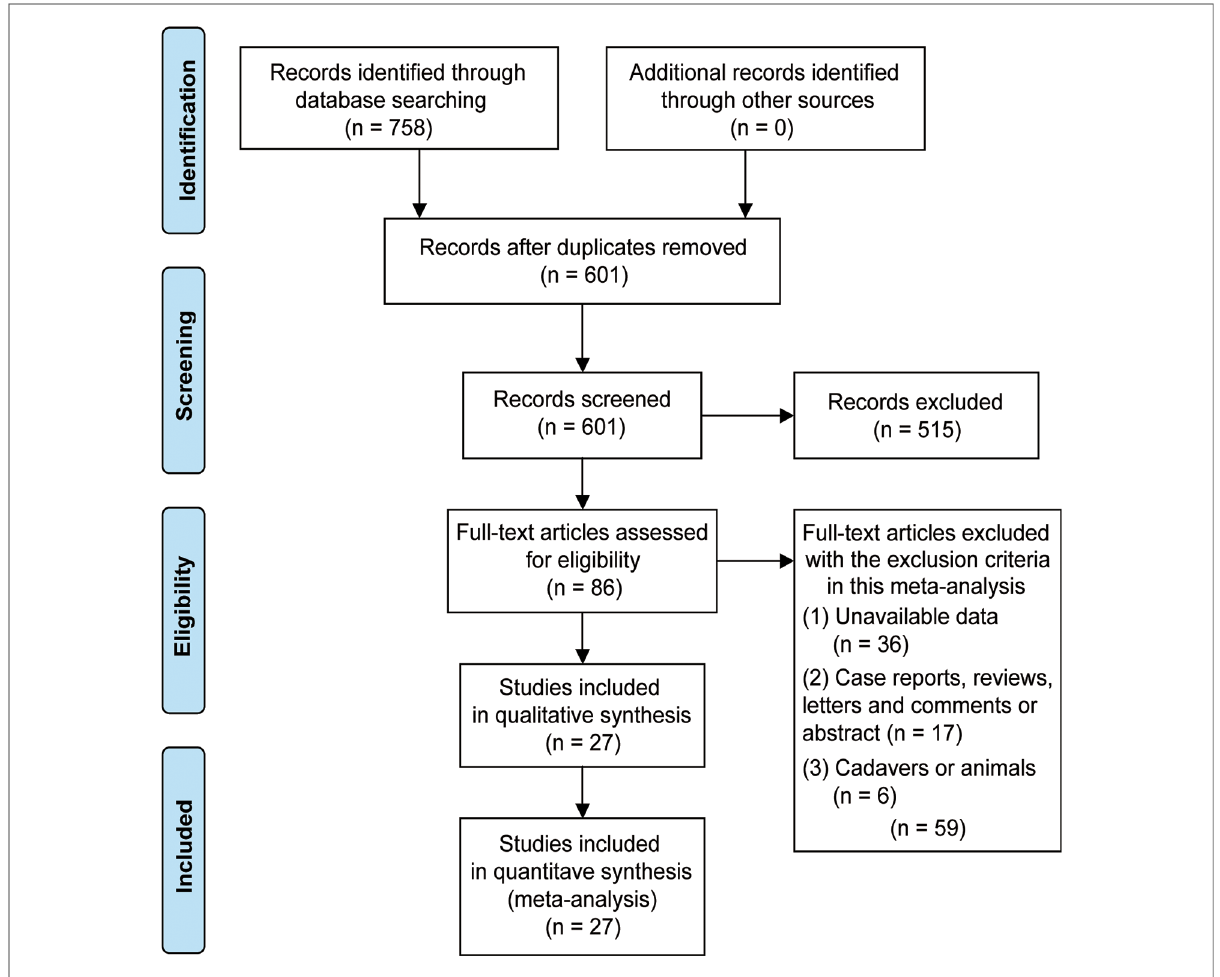
FIGURE 1 Flow diagram to show the process of the search strategy and relevant results for eligible